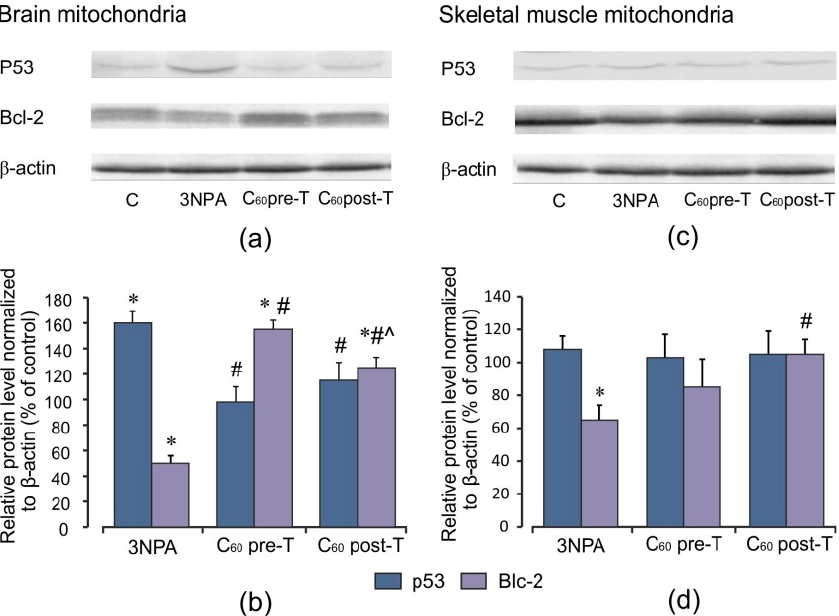
Figure 7. Effect of C 60 and 3-NPA administration on p53 and Bcl-2 protein expression in brain and skeletal muscle mitochondria. ( a , c ) Representative Western blot and ( b , d ) densitometric analysis of p53 and Bcl-2 protein contents. Protein extracts were separated by performing SDS PAGE and subsequently electroblotted onto PVDF membranes. The values of the p53 and Bcl-2 proteins were normalized to β -actin. Final Western blot figure as the histogram is expressed as mean percentages ( ± SD) over control values from two independent experiments. The control values are taken as 100%. Statistically significant differences are indicated as * p < 0 05 vs. control; # p < 0 05 vs. 3-NPA treated rats; ˆ p < 0.05 vs. C 60 pre-T